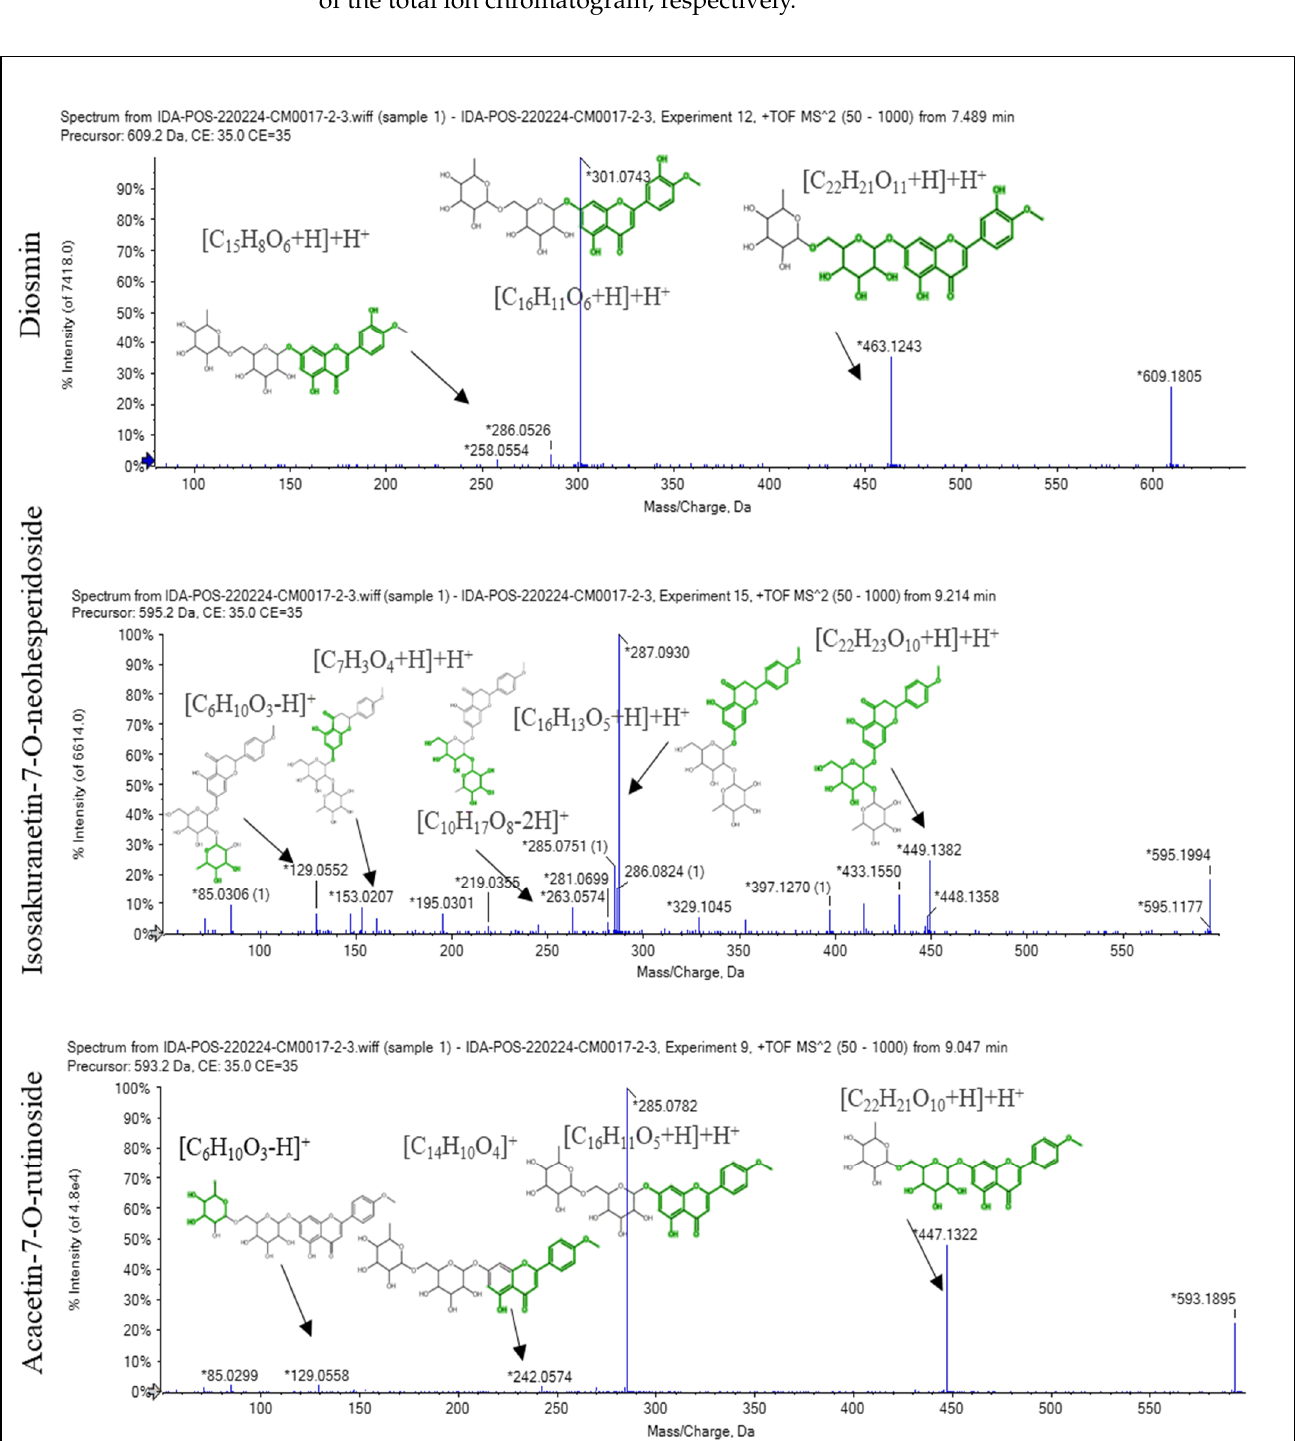
Figure 1. The fragmentation pattern of the main compounds recognized in the methanol extract of Salvadora persica stem bark: diosmin, isosakuranetin-7- O -neohesperidoside, and acacetin-7- O -rutinoside. * stands for m/z of [M+H] + , [M-H] − , and fragments of each compound.